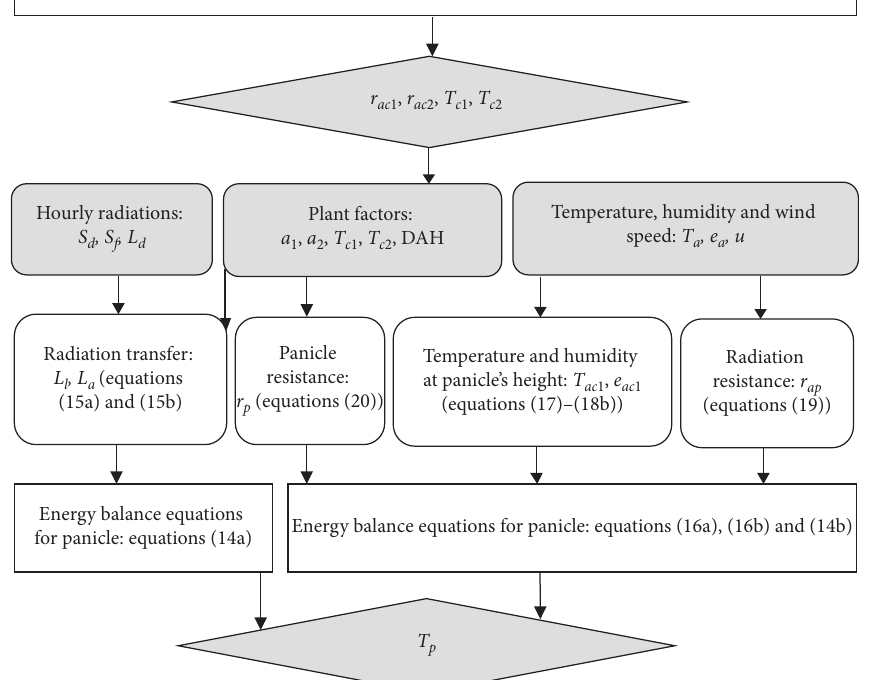
c 1 and T c 2 ) and panicle